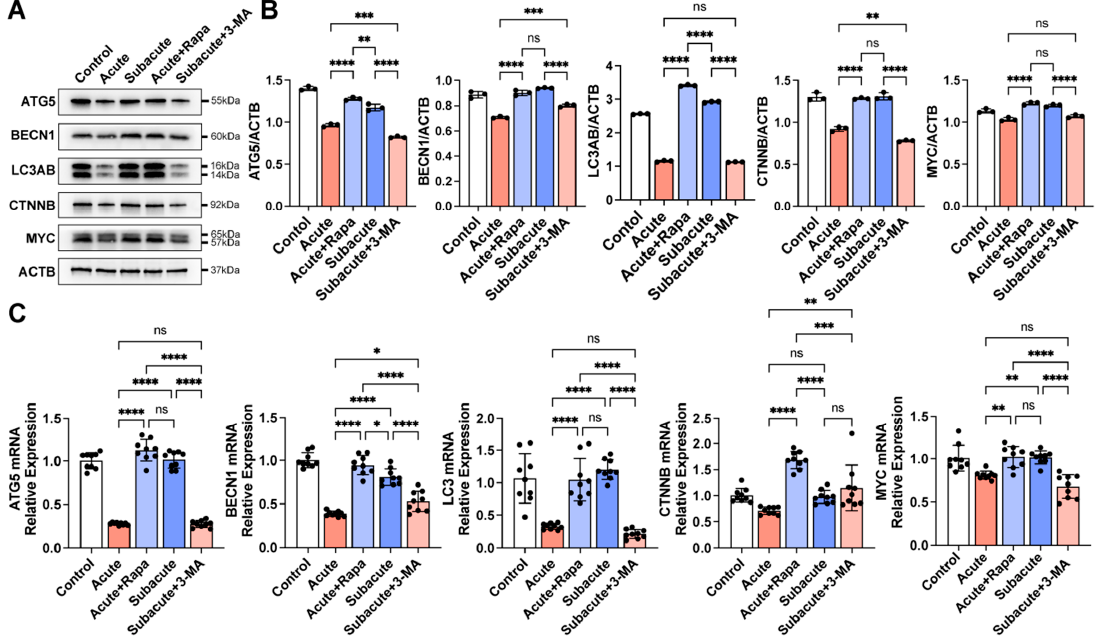
Figure 4. Intervening autophagy flux in hNSCs in TBI brain extracts at different phases. Markers of autophagy flux and the WNT/CTNNB pathway were detected ( A ). Related expression of proteins and mRNAs revealed that rapamycin (50 nM) could activate autophagy flux in the acute phase and 3-MA (2 μ M) could inhibit autophagy flux in the subacute phase ( B , C ). The activation of the WNT/CTNNB pathway showed a corresponding change in the autophagy flux ( B , C ). The black circle in B,C represented the individual value of each sample. *: p < 0.05; **: p < 0.01; ***: p < 0.001; ****: p < 0.0001; ns: p ≥ 0.05.